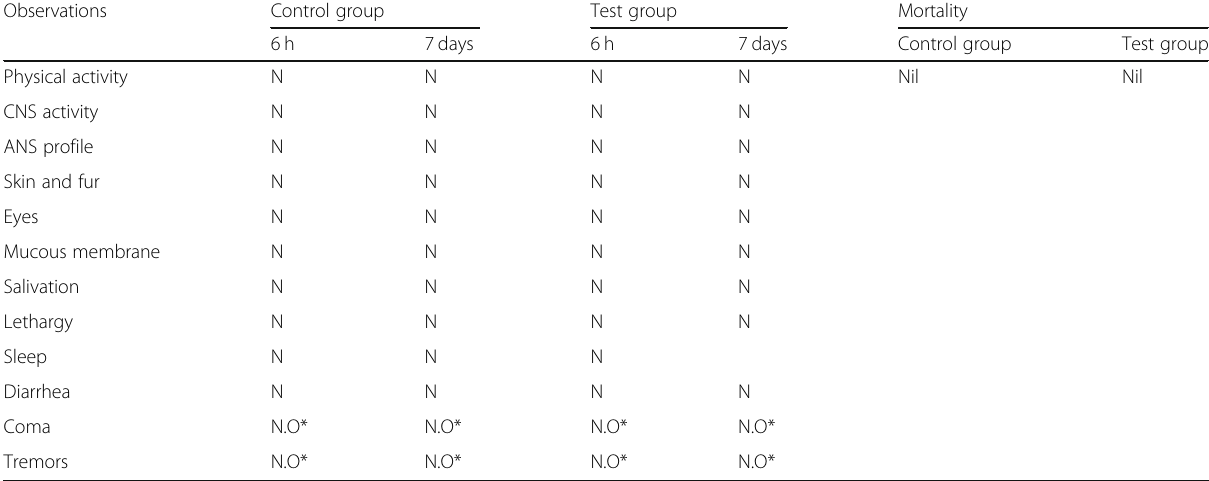
Table 2 Results showing the time course of onset of signs of toxicity in rats treated with 5000 mg/kg/b.w EEPM fruits Observations